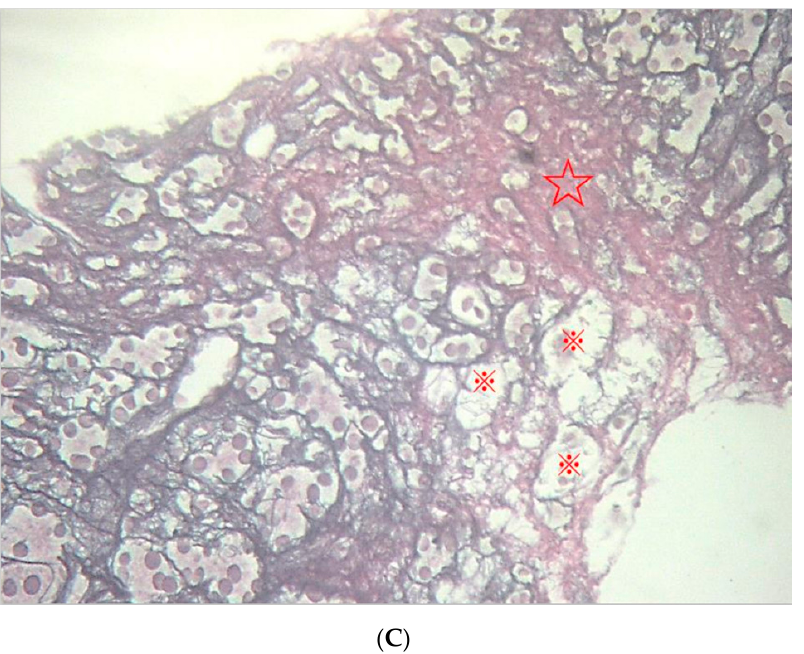
Figure 5. Pathology of liver biopsy (Case 4) at 13.5 months after hypofractionated radiotherapy (HFRT). ( A ) ×10 Hematoxylin and eosin staining; there are multiple fibrosis regions (arrows, as pale pink area) in liver biopsy fragment “A” area. ( B ) ×40 hematoxylin and eosin staining; irradiated background liver tissue fragment showed falling out of hepatocytes (arrowhead) in discolored part and fibrotic areas in pale pink part (arrows). ( C ) ×40 silver impregnation stain; in irradiated background liver tissue fragment “A” area of Figure 4A, hepatocytes fell out ( ※), and enlarged sinusoidal frame structure and increased collagen type 1 fibrosis ( ☆ ) were seen.